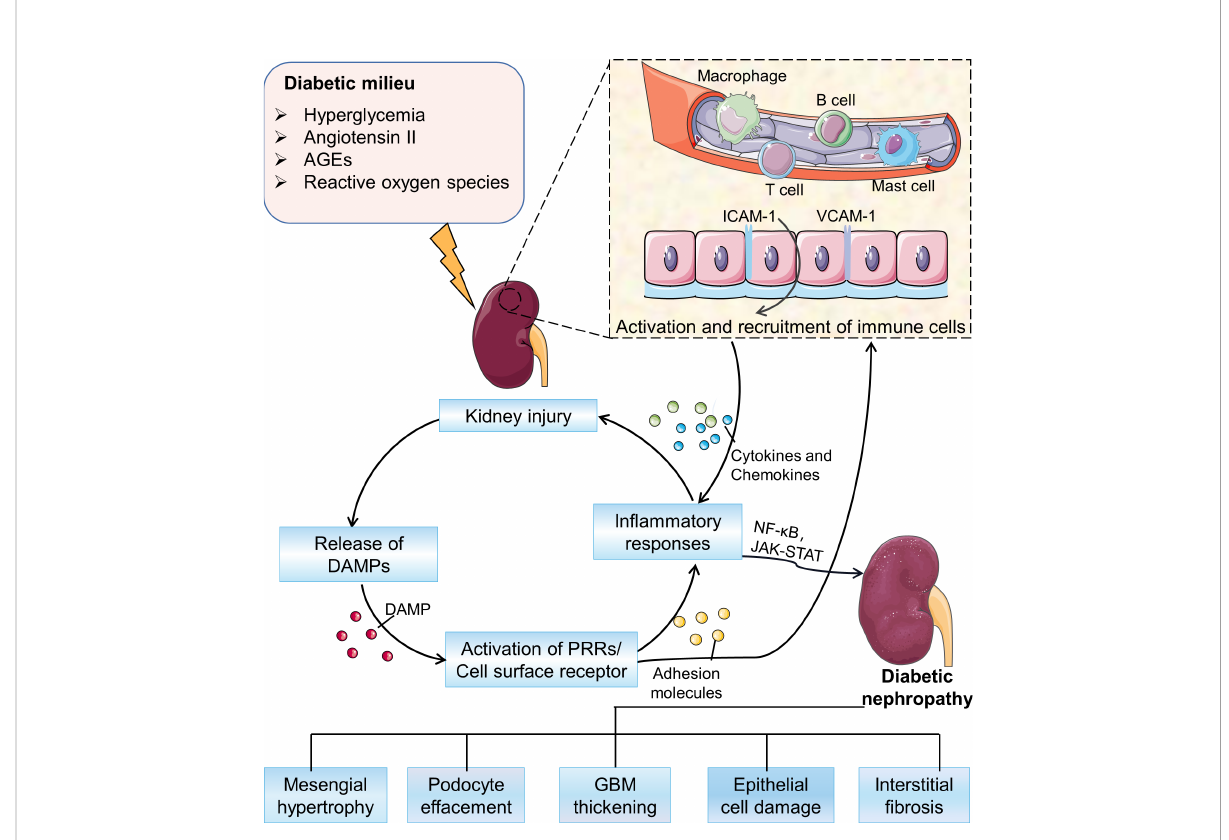
FIGURE 1 Overview of the pathogenesis of DN. In the diabetic milieu, hyperglycemia, advanced glycation end-products (AGEs), angiotensin II, and oxidative stress activate a variety of signaling cascades driving the recruitment and activation of immune cells to promote the development of in fl ammation and ultimately leading to a series of pathological changes in DN. AGEs, advanced glycation end products; DAMPs, damage associated molecular patterns; PRRs, pattern recognition receptors; GBM, glomerular basement